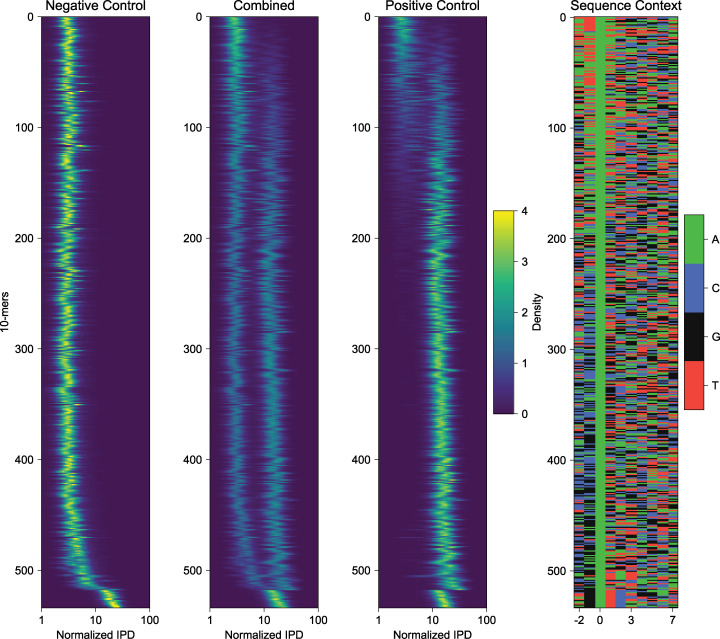
k-mer analysis of negative and positive control sequences reveals sequence biases of IPD measurements of EcoGII modified DNA.Decomposition of measured IPD values for represented 10-mers in a 10 bp window informed by known PacBio polymerase footprint. Heatmaps are visualizing individual histograms of normalized IPD for each well-respresented 10-mer in the template sequence. The ‘Combined’ panel is an overlay of both negative and positive control histograms, and the ‘Sequence Context’ panel visualizes the 10-mer sequences in color format. This analysis reveals a subset of contexts where methylation efficiency and/or detection is subtly altered by template base composition.